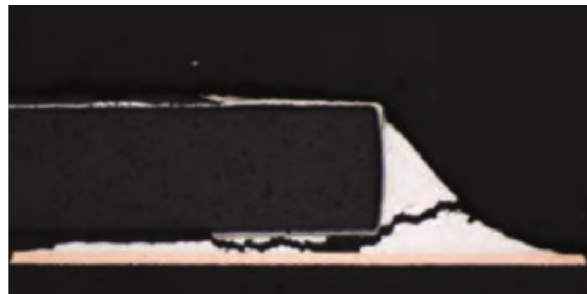
Fig. 16 Investigation of the solder cracking mechanism under ther- mal stress by experiment using a fillet shape. Reproduced with per- mission from Ima